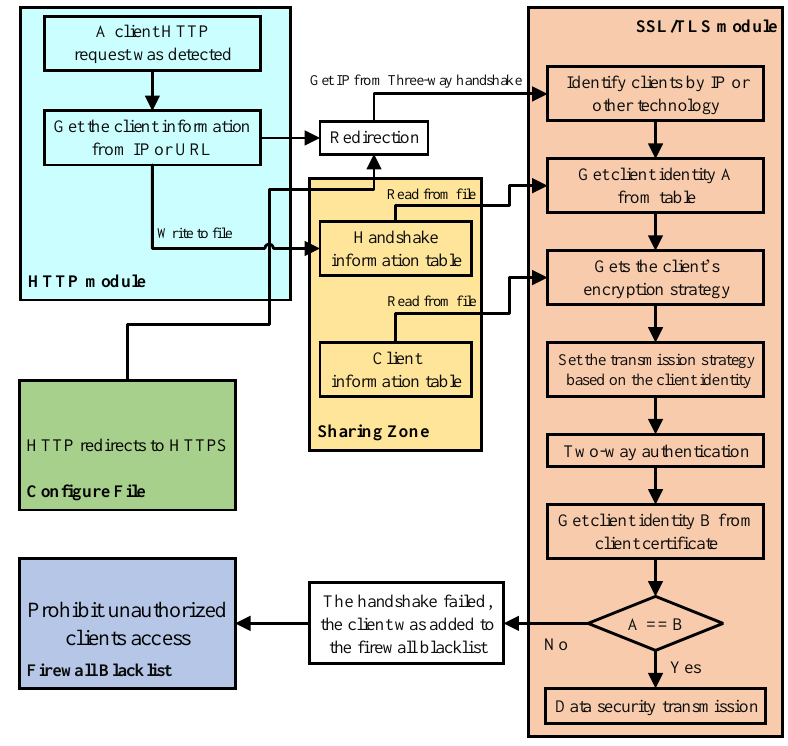
Figure 4. A flowchart of client-aware negotiation based on